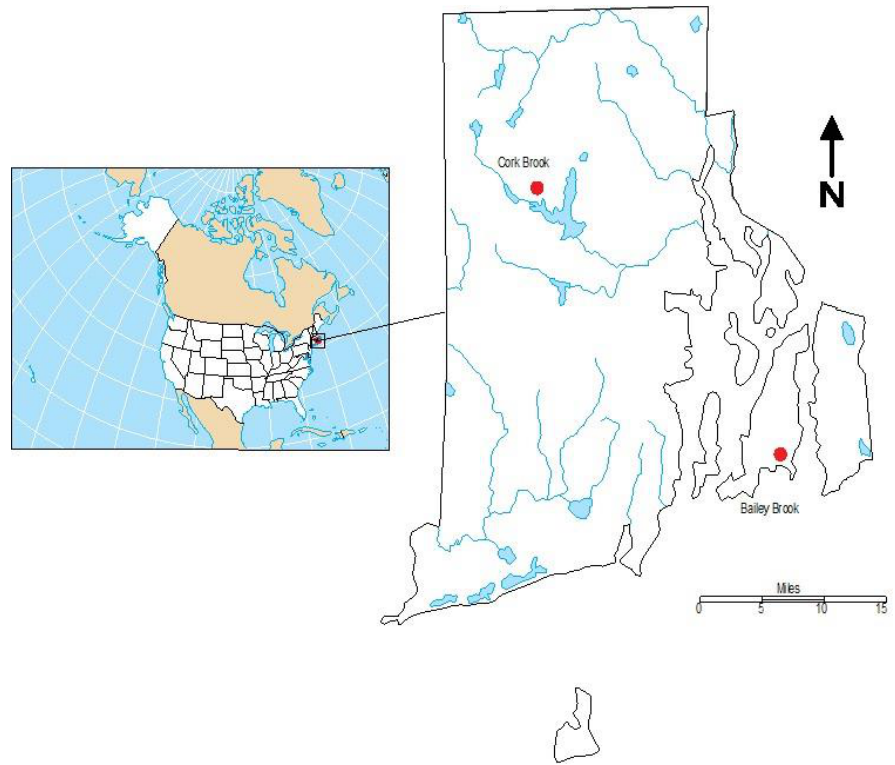
Figure 1. Map of the state of Rhode Island, USA. Field sample locations identified by red circles on map. Rhode Island map to scale.